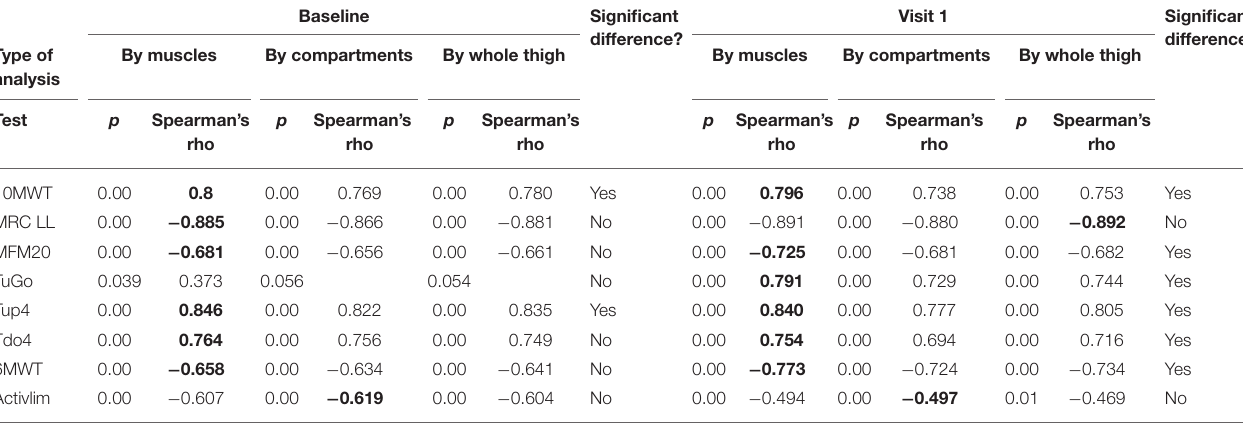
TABLE 2 | Correlations between fat fraction and muscle function tests with the three methods of analysis. Baseline Significant Visit 1 Significant difference? difference? Type of By muscles By compartments By whole thigh By muscles By compartments By whole analysis